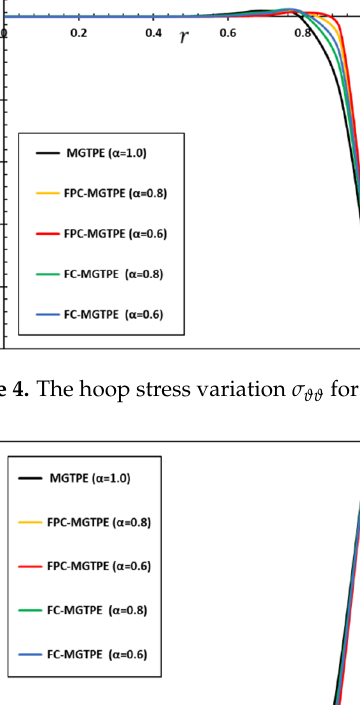
Figure 3. The radial stress variation 𝜎 (cid:3045)(cid:3045) for different fractional derivatives.